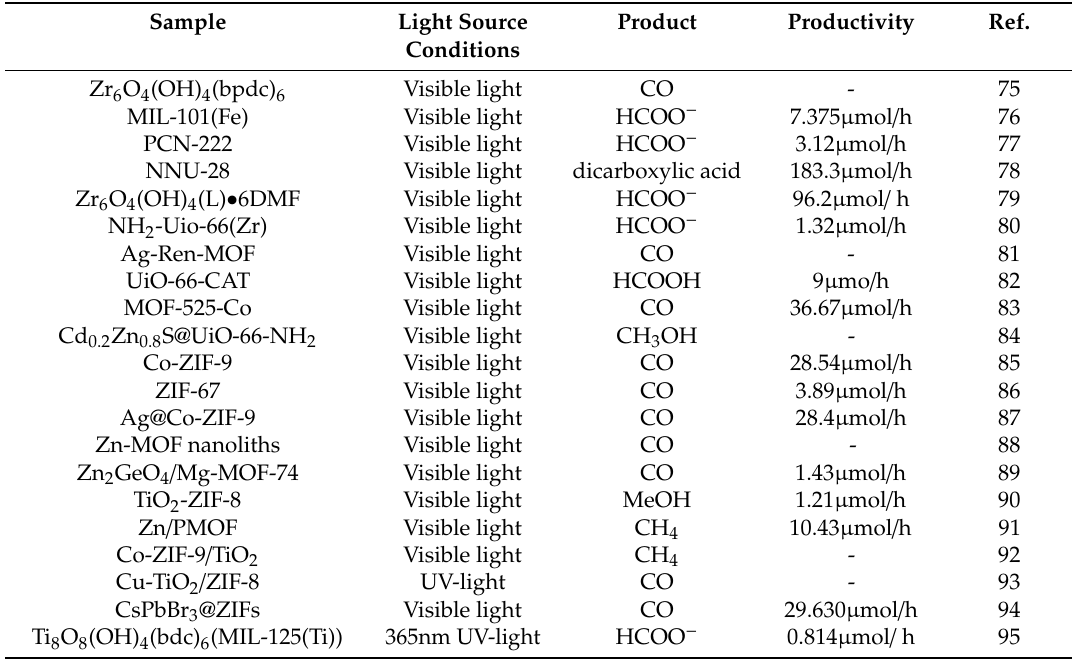
Table 1. the research progress of several typical metal-organic frameworks (MOF) materials for photocatalytic CO 2